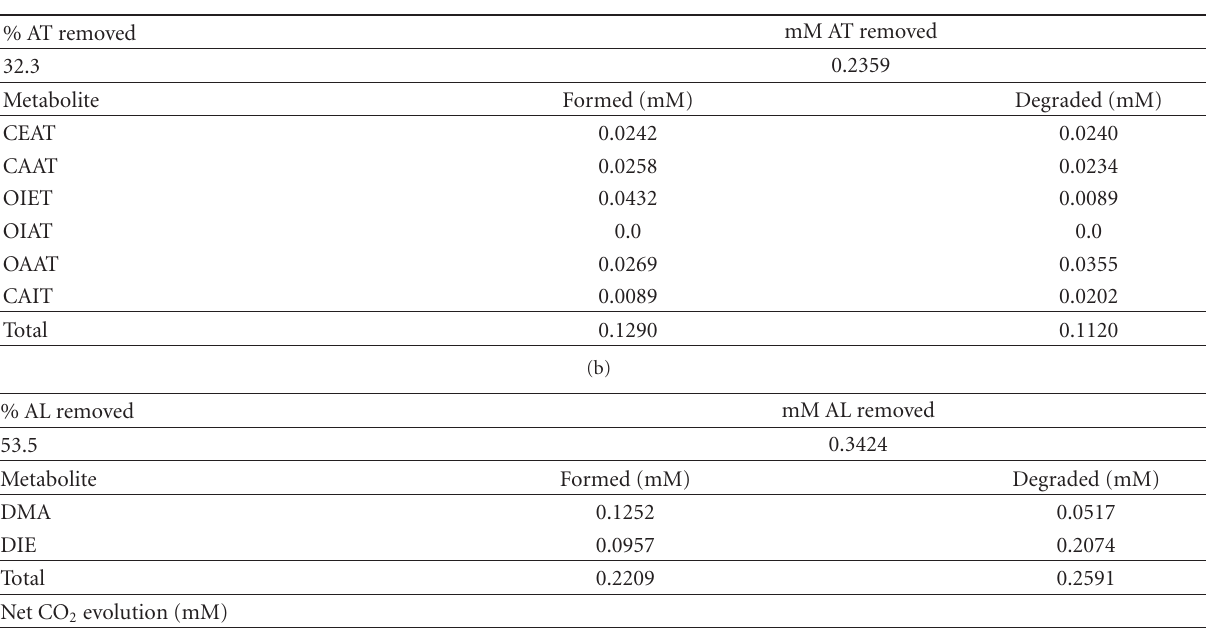
Table 3: Overview of AT and AL transformation and of the production and further transformation of metabolites within the EES-treated soil. (a) AT transformation. (b) AL transformation and the Net CO 2 evolved during